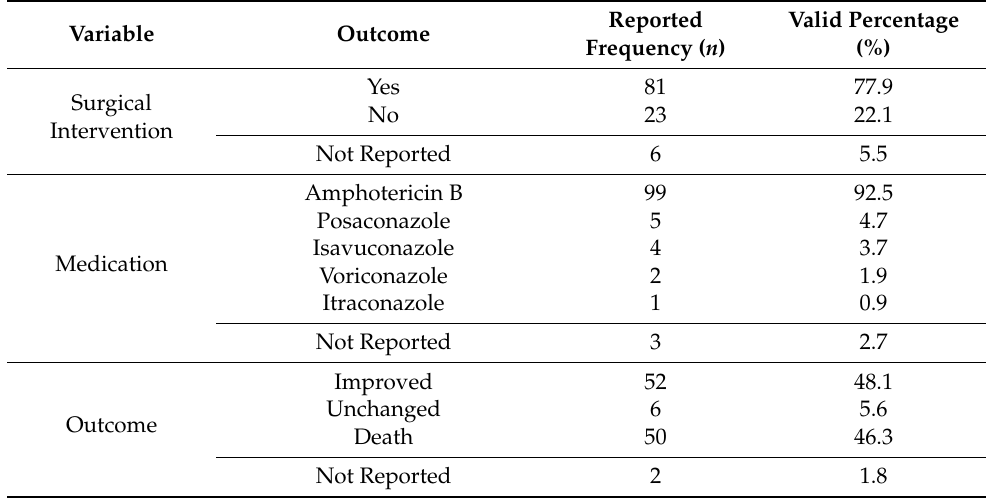
Table 6. Management and Outcome of COVID-19-associated Mucormycosis (CAM) Cases,